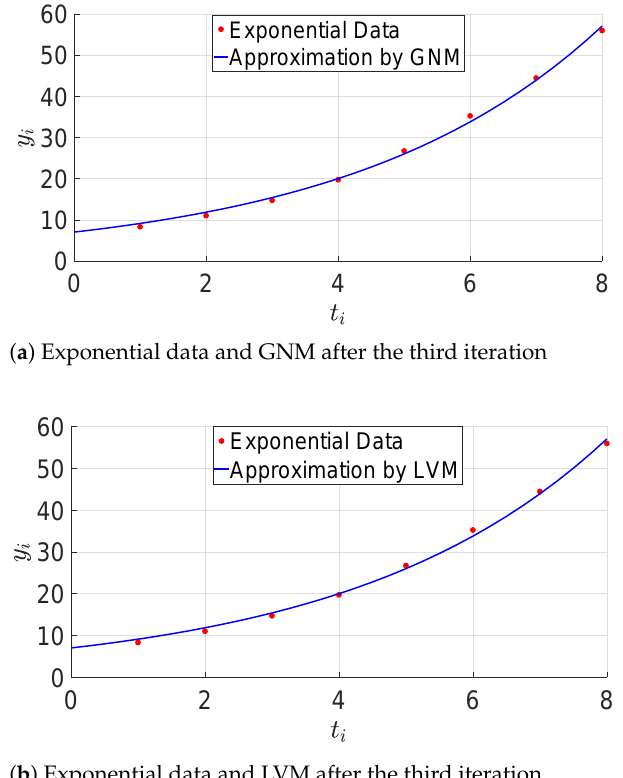
Figure 5. Exponential model approximation. GNM, Gauss–Newton Method. LVM, Levenberg– Marquardt Method.